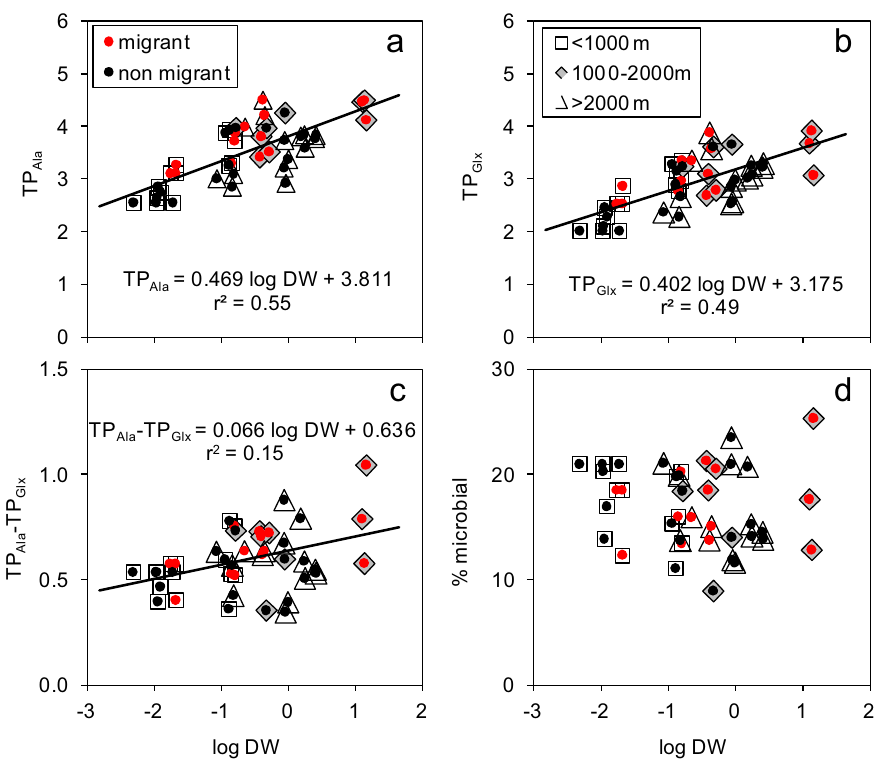
Figure 4. Relationships between trophic positions including ( a ) microbial + metazoan (TP Ala ) or ( b ) only metazoan (TP Glx ) food webs and ( c ) their difference (TP Ala − TP Glx ) or ( d ) the fractional contribution of microbial food web (%microbial) with log-transformed individual dry weight (DW, mg). As the slopes for migrant (black dots) and non-migrant (red dots) were no significantly different (ANCOVA, P > 0.05), the regression lines for the whole data are indicated (P < 0.001) along with the corresponding determination coefficients (r 2